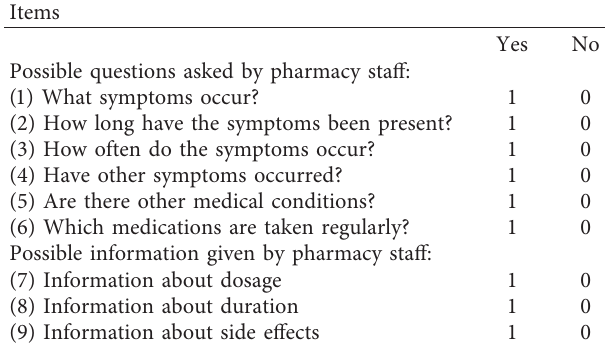
Table 3: Assessment